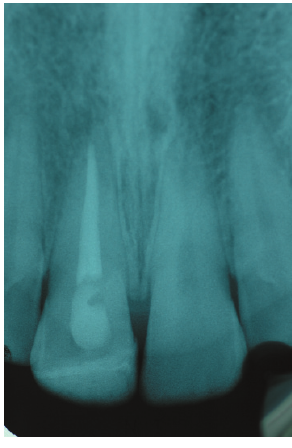
Figure 2- Initial radiograph, showing